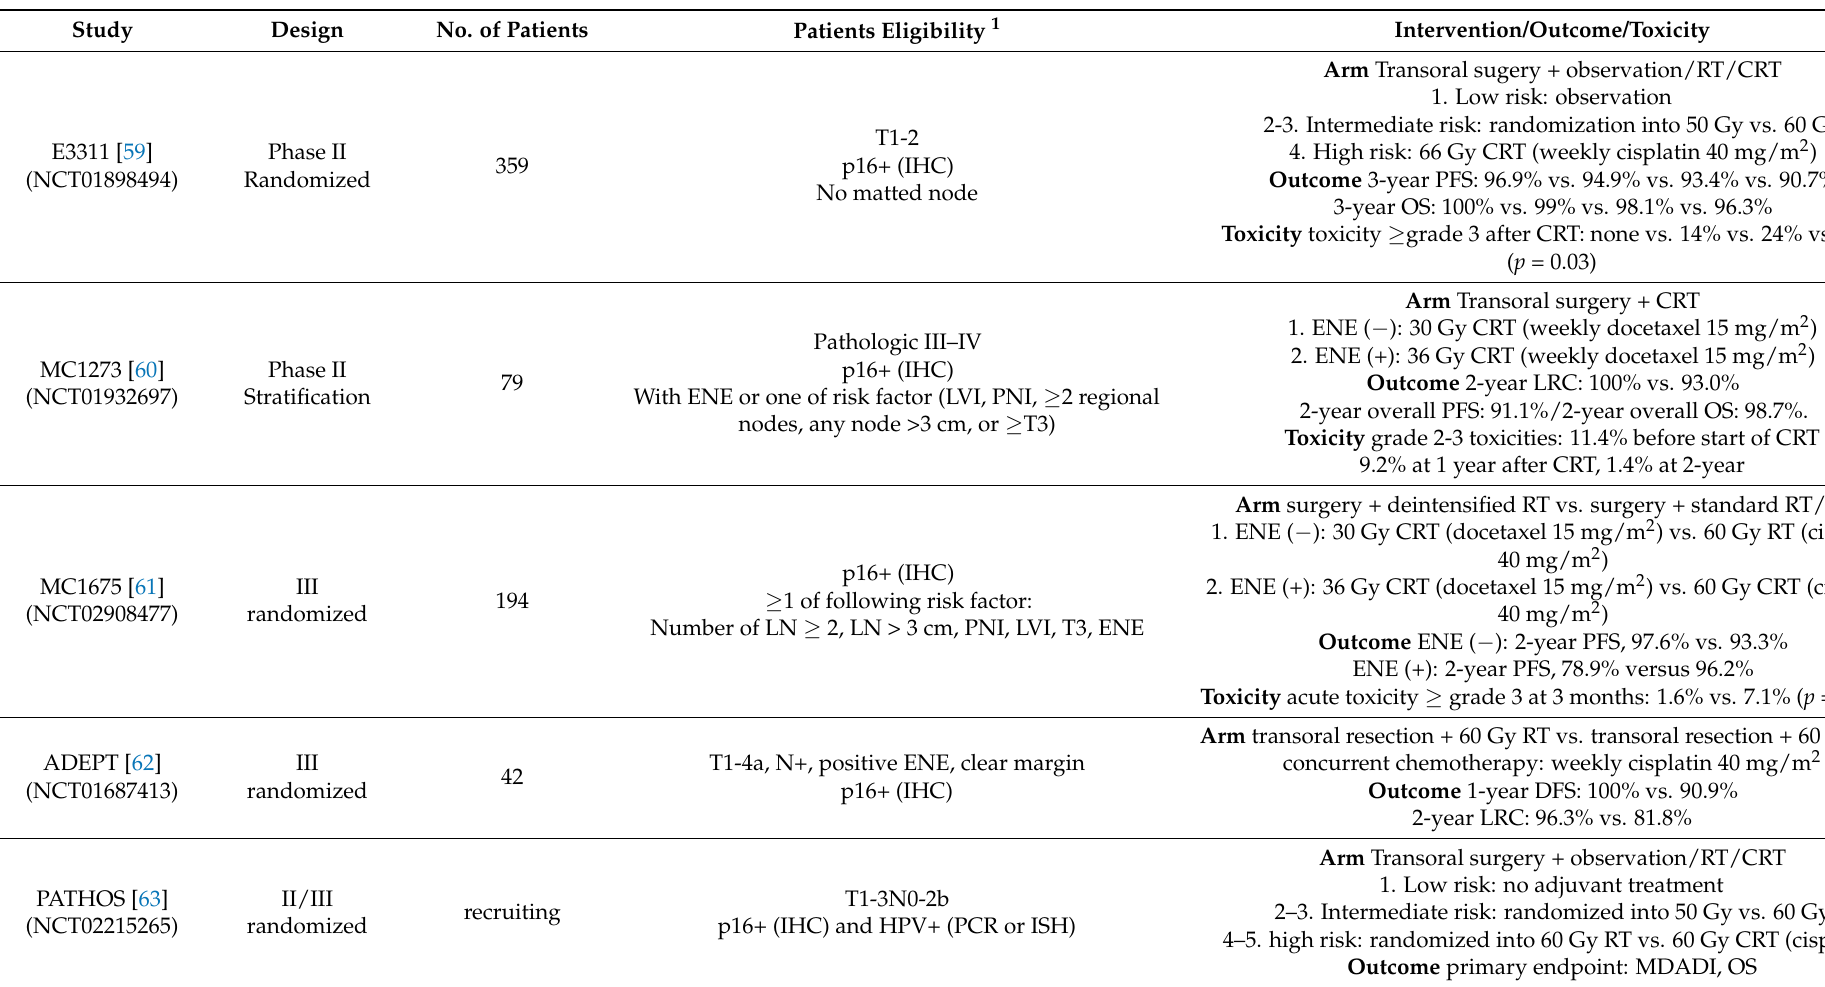
Table 3. Deintensification trials in the postoperative